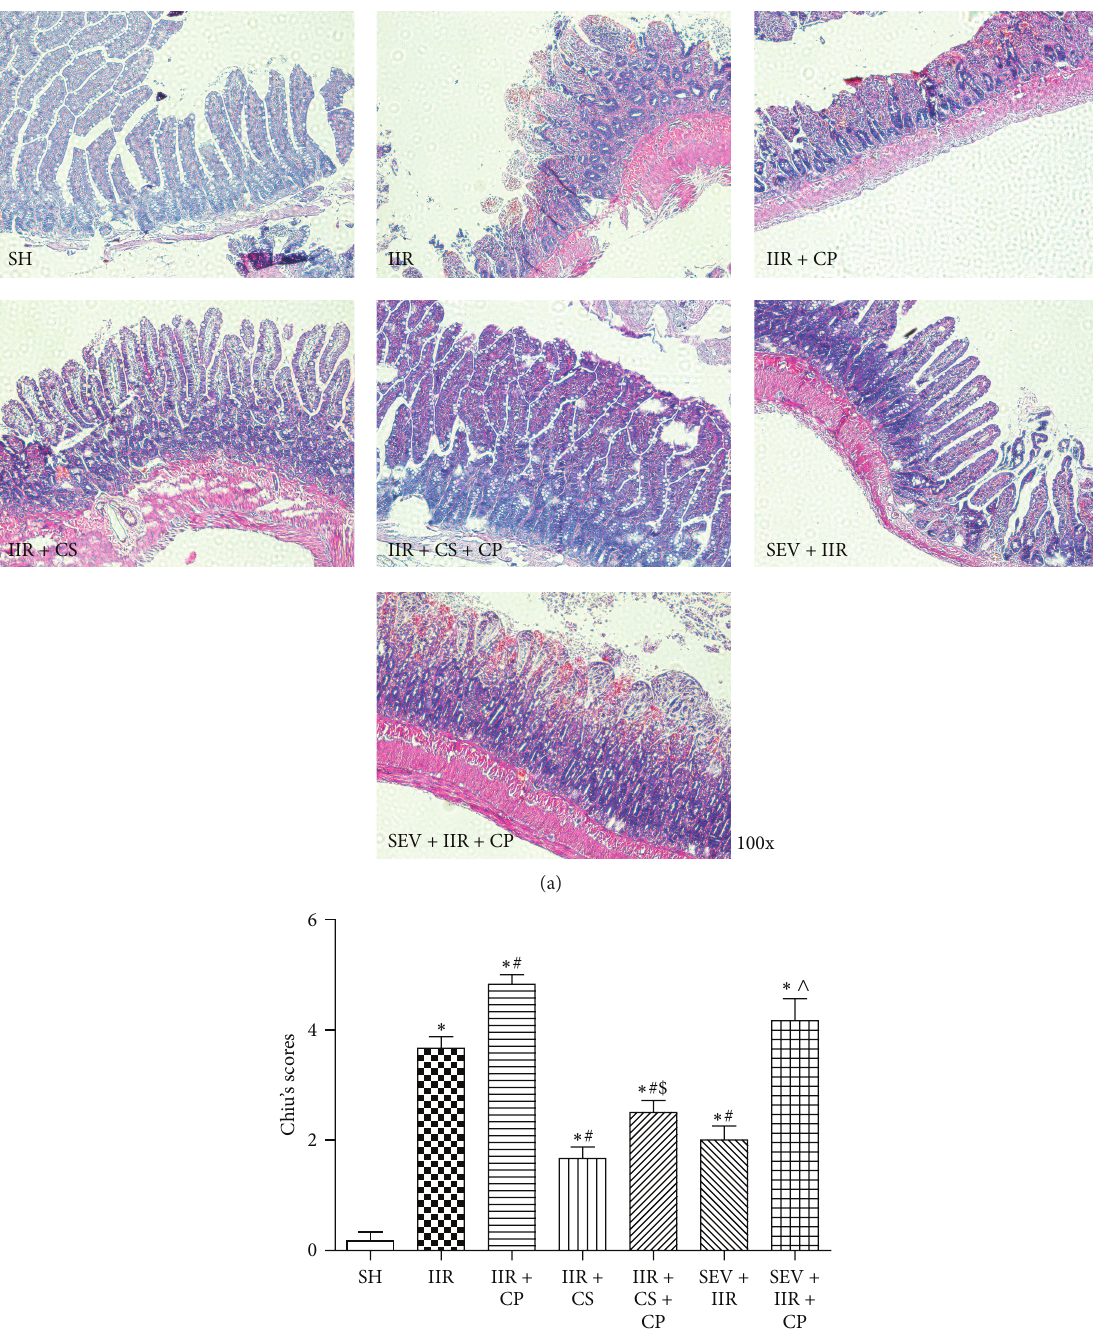
Figure 2: Morphological changes of intestine and intestinal histological score under light microscope after IIR injury. (a) is representative image of SH group (Sham-operated group), IIR group (75 min intestinal ischemia and 2 h reperfusion), IIR + CP group (IIR group + Compound 48/80 1mg/kg), IIR + CS group (50 mg/kg cromolyn sodium treated IIR group), IIR + CS + CP group (50 mg/kg cromolyn sodium treated IIR group + Compound 48/80 1mg/kg), SEV + IIR group (2.3% sevoflurane pretreated IIR group), and SEV + IIR + CP group (2.3% sevoflurane pretreated IIR group + Compound 48/80 1mg/kg), (HE staining, × 100). Bar graph in (b) quantified the intestine histological scores. Results are expressed as Mean ± SEM. 𝑛 = 6 per group. ∗ 𝑃 < 0.05 versus SH group, # 𝑃 < 0.05 versus IIR group, $ 𝑃 < 0.05 versus IIR + CP group, & 𝑃 < 0.05 versus IIR + CS group, and ∧ 𝑃 < 0.05 versus SEV + IIR